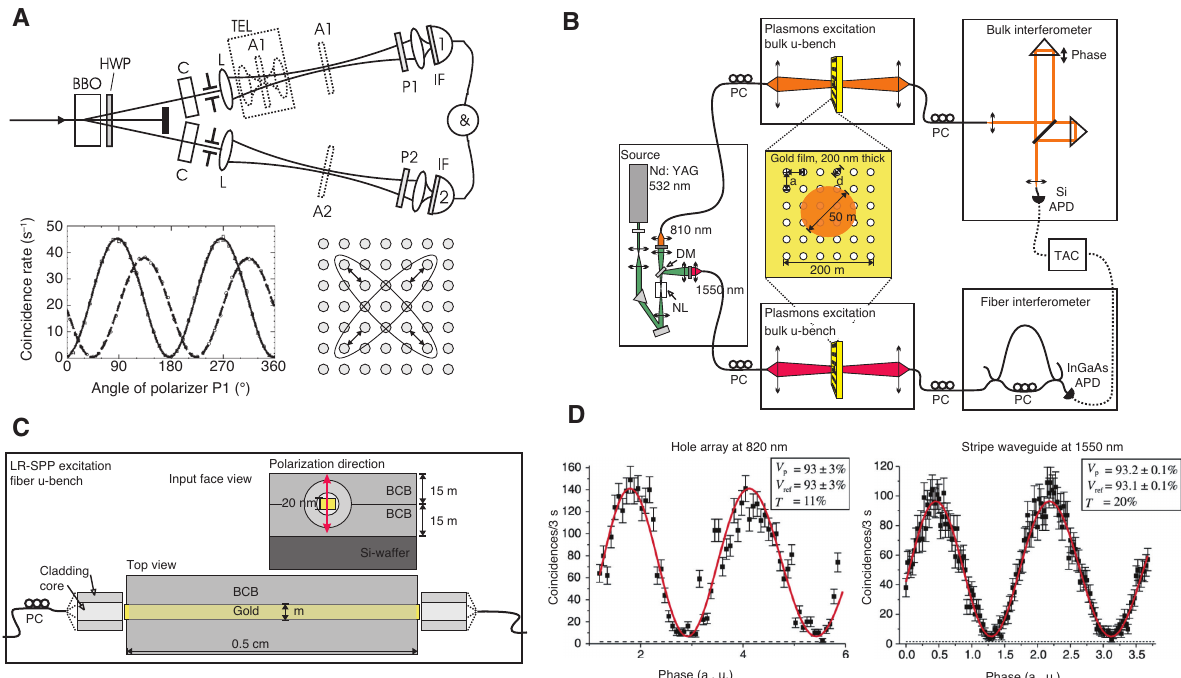
Figure 8: Experiments demonstrating entanglement preservation in plasmonic systems. (A) First experiment that demonstrated plasmon-assisted transmission of entangled photons. This was confirmed through the measurement of two-photon quantum interference after photon-plasmon-photon conversion, which demonstrated the preservation of entanglement. The experimental setup used a β barium borate (BBO) nonlinear crystal to generate entangled photon pairs that were passed through an array of gold. The generated light beams were detected by two single-photon detectors. C, compensating crystals; HWP, half-wave plate; IF, interference filters; L, lens; P1 and P2, polarizers; TEL, confocal telescope. Reproduced from Ref. [115]. (B) Schematic of the experimental setup demonstrating energy-time entanglement in a plasmonic system. APD, avalanche photodiode; DM, dichroic mirror; NL, nonlinear crystal; PC, polarization controller; TAC, time to analogue converter. (C) Schematic of the LR-SP waveguide. BCB, benzocyclobutene. (D) Experimental interference fringes produced by the setups shown in (B) and (C). V represents the visibility of the interference fringes after p plasmonic conversion. Furthermore, V describes the visibility in the absence of plasmonic conversion, and T is the transmittance of the net plasmonic setup. (B–D) Reproduced from Ref.